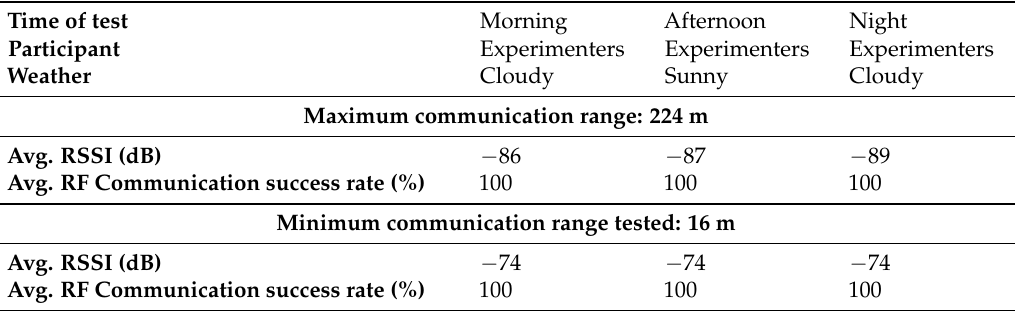
Table 3. Stationary test